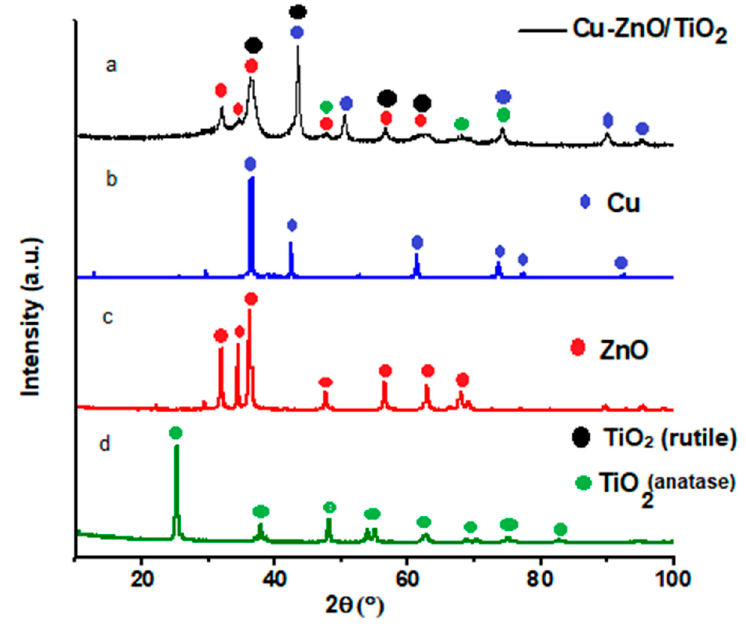
Figure 1. XRD pattern of the sonochemically synthesised Cu-ZnO/TiO 2 (CZT-2) nanocomposite photocatalyst ( a ) Cu ( b ) ZnO ( c ) and TiO 2 ( d ) nanoparticles.